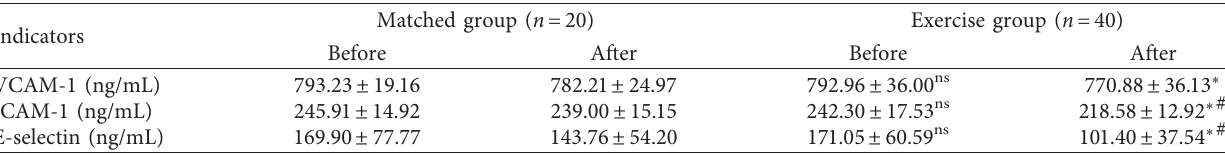
Table 2: Endothelial dysfunction markers in obese children and adolescents before and after